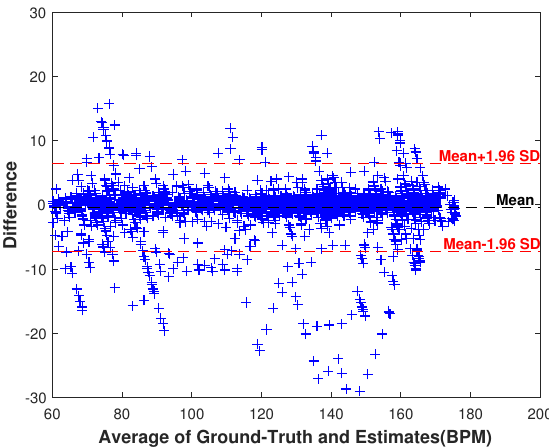
Figure 5. The Bland–Altman plot of the estimates of our proposed approach on the 22 datasets. The limit of agreement (LOA) was [ − 7.18, 6.46] BPM (standard deviation σ = 3.48 (BPM).